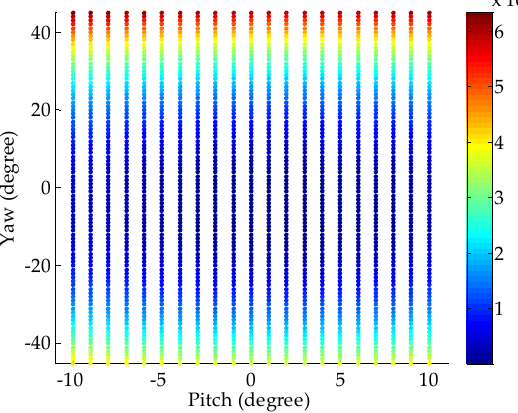
Figure 3. RMS versus the posture of the camera.